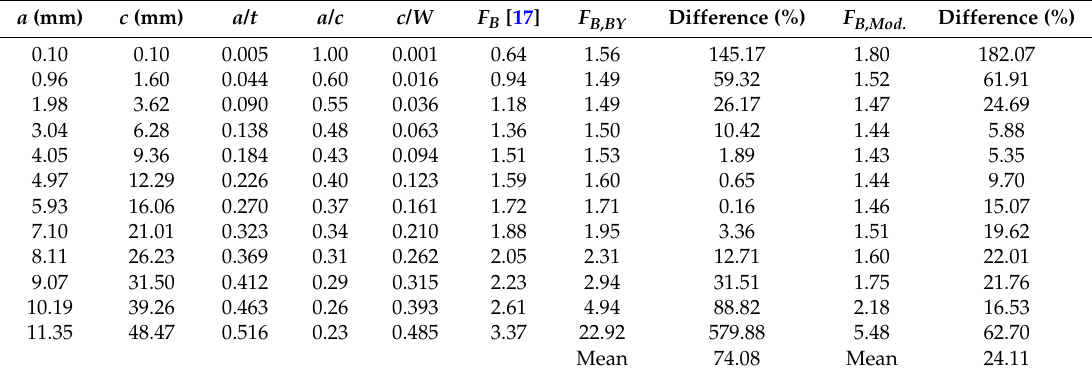
Table 8. Comparison of dimensionless stress intensity factor values from the Baik-Yamada formula, the modified formula and the literature results of the empirical formula at point B